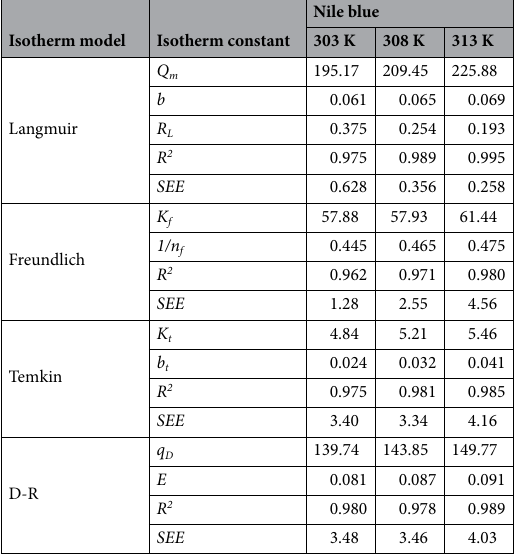
Table 1. Isotherm parameters.